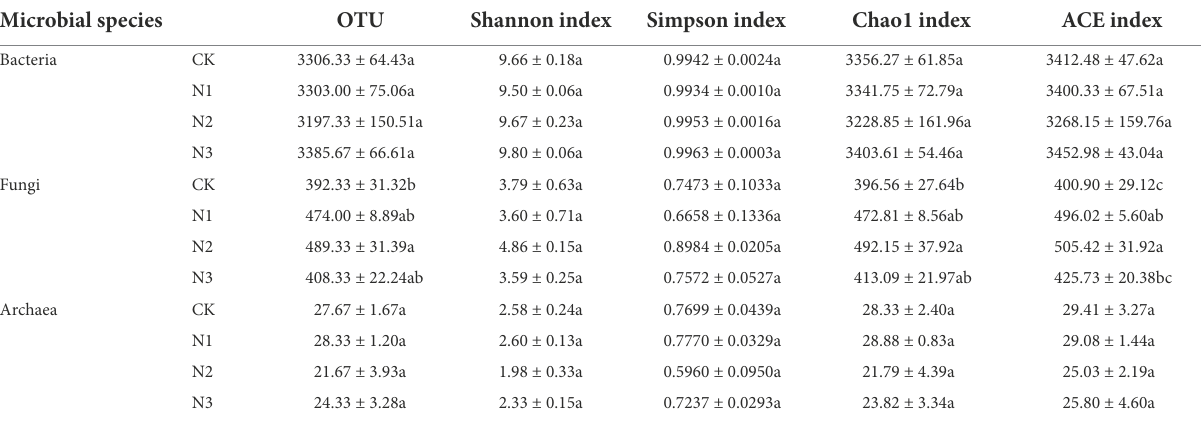
TABLE 2 Effects of N addition on soil microbial OTUs and the α -diversity